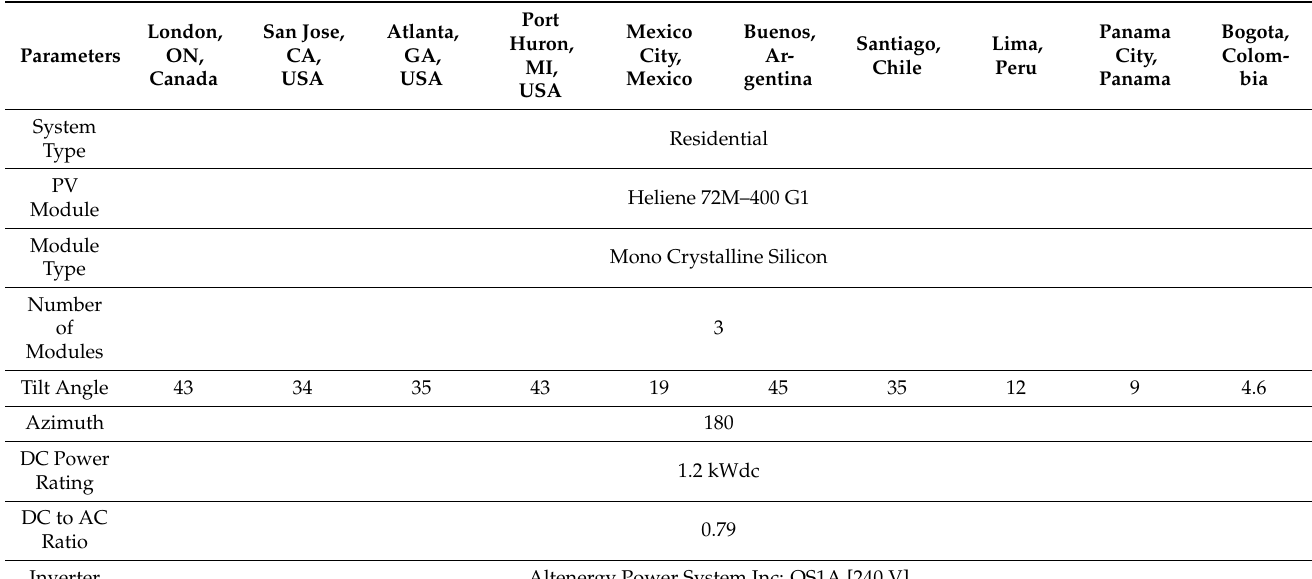
Table 3. Input parameters of